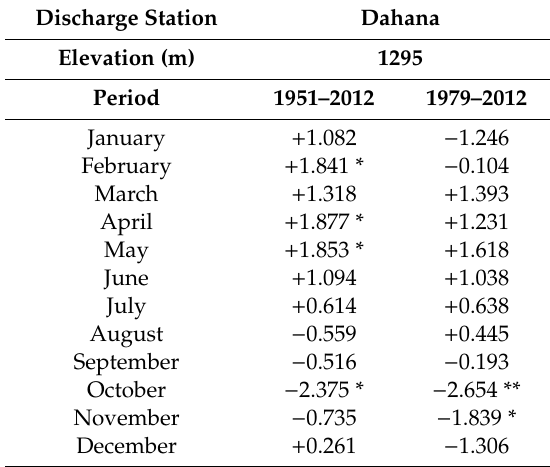
Figure 7. Sen’s slope of ( a ) the annual mean precipitation and ( b ) annual air temperature in the Kofarnihon River Basin, Central Asia. Table 8. The seasonal streamflow trends and the original Mann–Kendall test in the Kofarnihon River Basin, Central